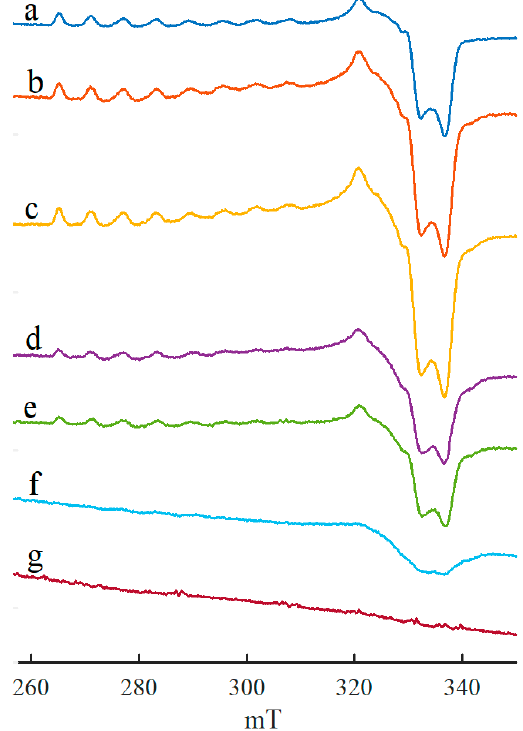
Figure 2. Time dependence of EPR spectra of the catalytic system formed on the basis of Co(acac) 2 – AlEt 3 in toluene in an argon atmosphere under otherwise equal time conditions: ( a ) 0.1 min, ( b ) 0.5 min, ( c ) 1 min, ( d ) 5 min, ( e ) 10 min, ( f ) 15–45 min, ( g ) 60–90 min (Some spectra (Figure 2f,g, and et seq.), apart from the paramagnetic signals, contain a broadened ferromagnetic resonance signal. These signals are due to the transformation of paramagnetic intermediates into nano-sized cobalt-containing structures. The rate of the intermediate transformation into a nanostructure is determined, other things being equal, by the nature of the cocatalyst.). Spectrum (a) was taken from